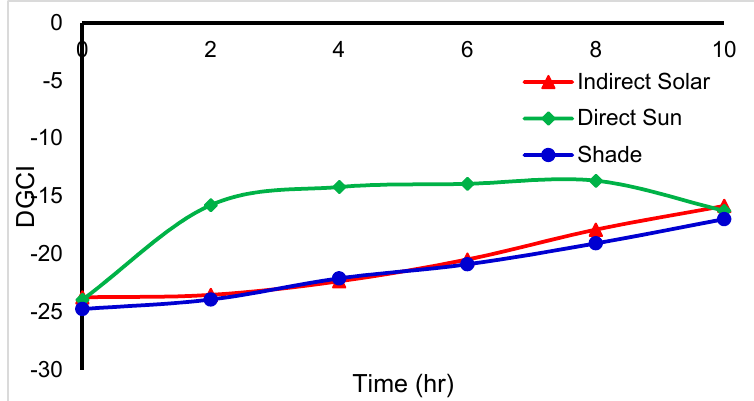
Figure 11. Mint DGCI degradation during different dying methods ( n = 3).